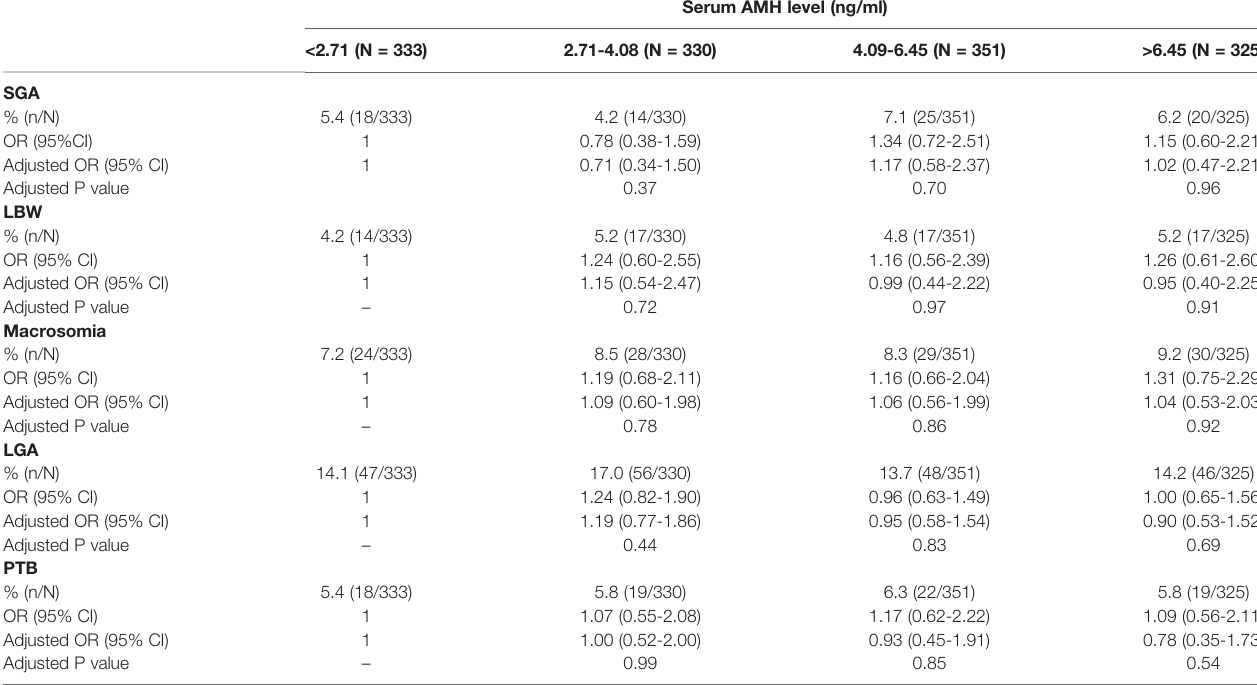
The analyses were adjusted for the maternal age, BMI, duration of infertility, type of infertility (Primary/Secondary infertility), basal antral follicle count, fertilization method (IVF/ICSI), endometrial thickness on the trigger day and development stage of the embryo (cleavage/blastocyst). OR, odds ratio; CI ,con fi dence interval; SGA ,small-for-gestational age; LBW ,low birthweight; LGA, large-for-gestational age; PTB, preterm